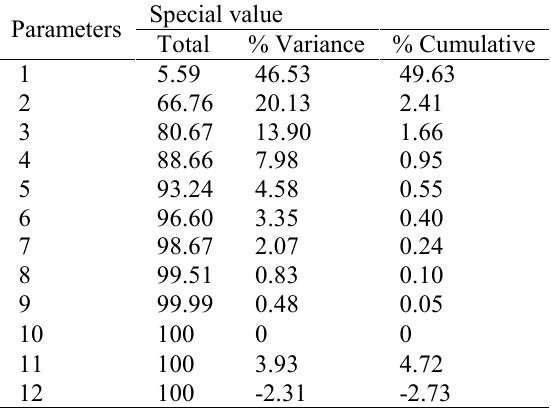
Table 3. Percentage of total parameters in the study area